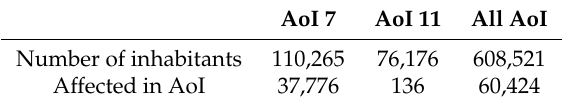
Table 2. Population data obtained from the information from